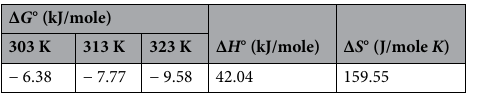
Table 3. Thermodynamic parameters for the adsorption of MB onto BB.